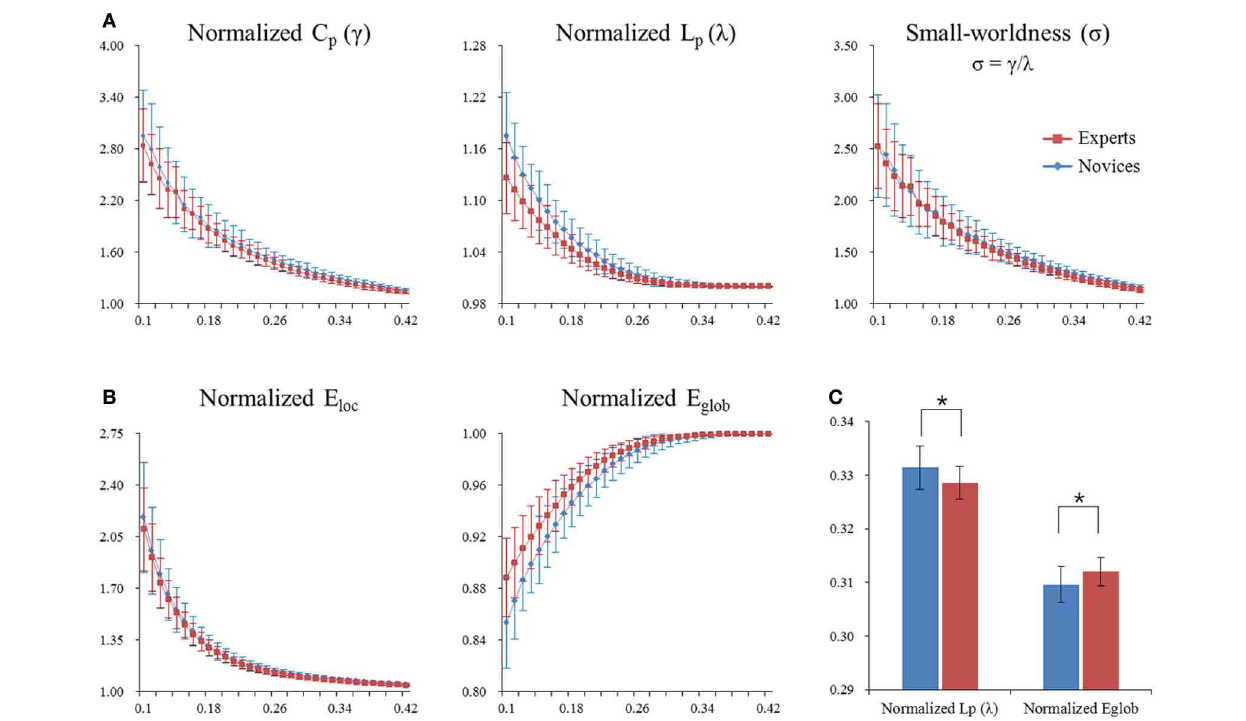
FIGURE 3 | Normalized global network measures of the whole-brain functional network in both groups. The global measures included small-word parameters (panel A ) and network efficiency (panel B ). Asterisks denote significant differences (permutation-based p -value < 0.05). Significant differences were found in normalized path length λ (permutation-based